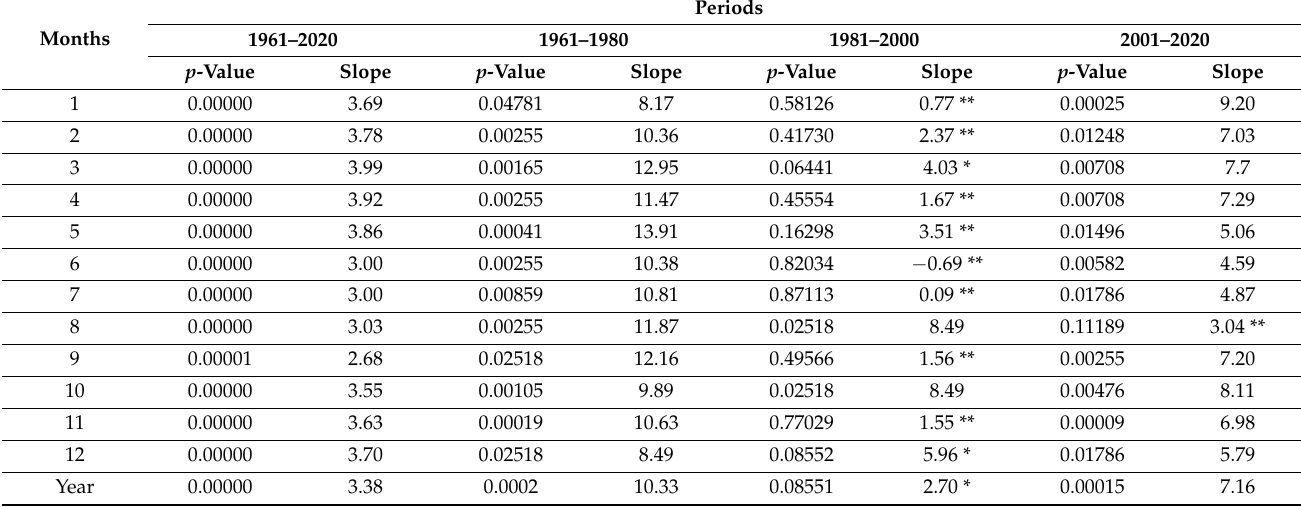
Table 1. Trend analysis of sea level rise (mm/year) in the Hon Dau station using the Mann–Kendall test and Sen’s